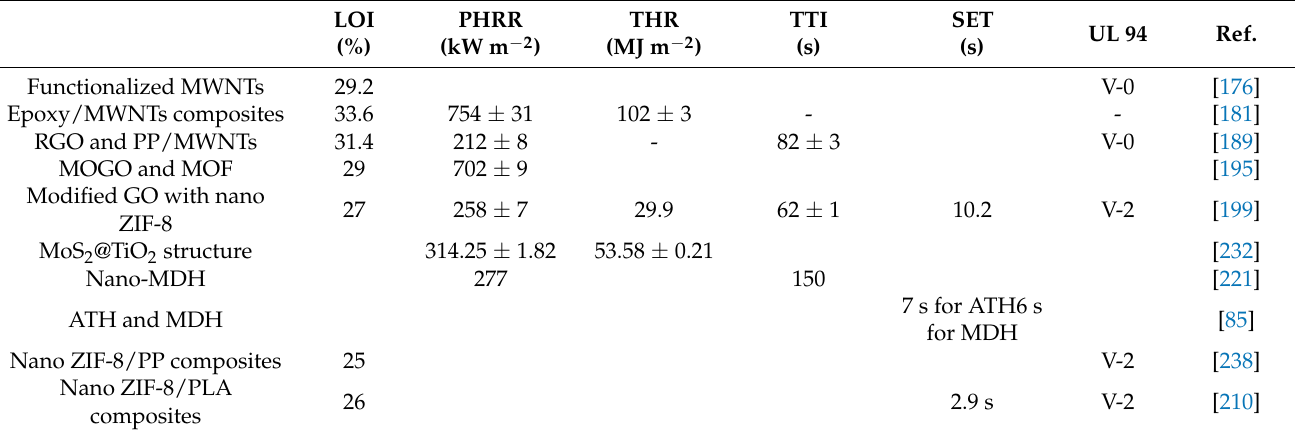
Table 9. Major data summarizing the fire performance for various samples.